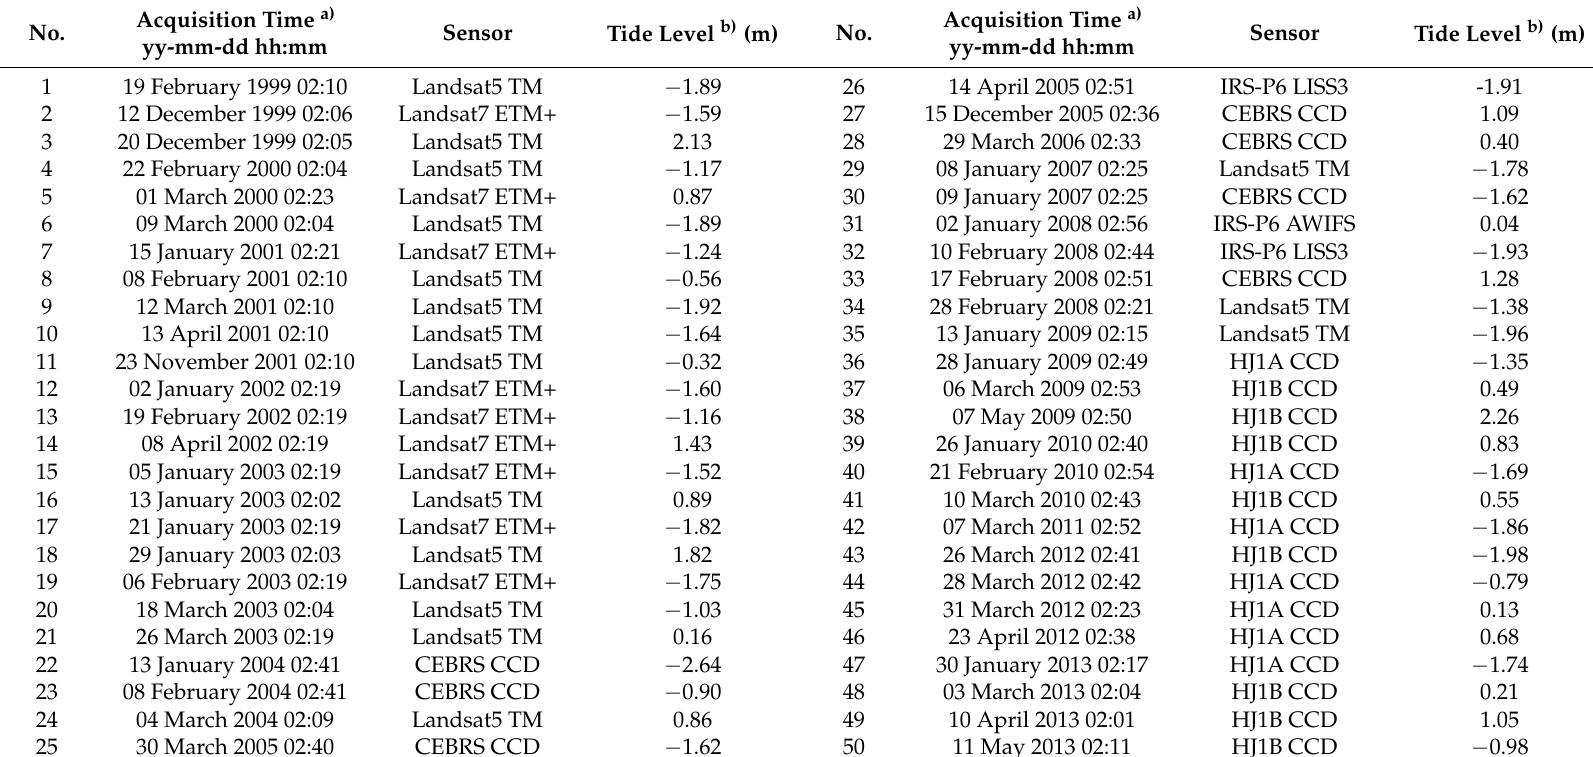
Table 1. Summary of images used for extraction of laver aquaculture